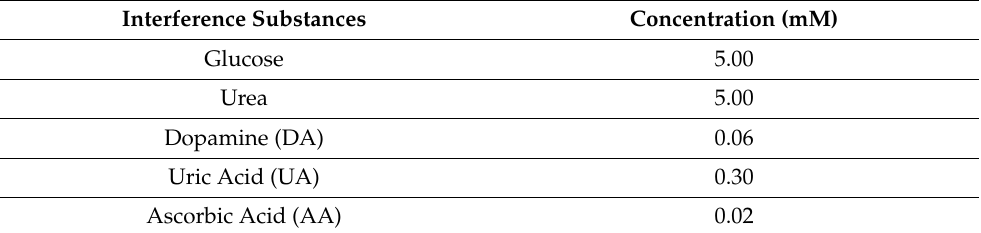
Table 3. The concentration of different interference substances.